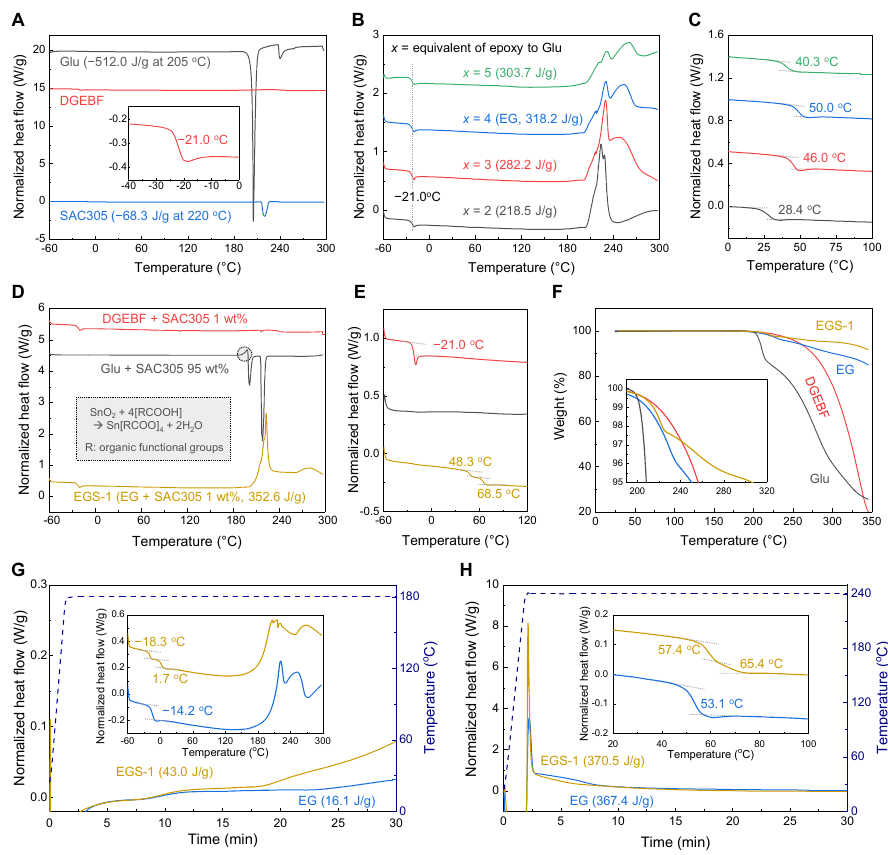
Figure 2. Thermal reaction between DGEBF, Glu, and SAC305. ( A ) Dynamic DSC results of Glu, DGEBF, and SAC305. The inset graph is an expanded curve of DGEBF, exhibiting uncured T g . ( B , C ) 1st dynamic ( B ) and 2nd dynamic ( C ) DSC curves between DGEBF and Glu with different equivalent ratios ( x ). The mixture of DGEBF and Glu with x = 4 was deemed to be optimal and abbreviated as EG. ( D , E ) 1st dynamic ( D ) and 2nd dynamic ( E ) DSC curves of DGEBF/Glu/EG with SAC305. Inset chemical reaction ( D ) is related to the marked exothermic reaction. EG with 1 wt% of SAC305 was designated as EGS-1. ( F ) Dynamic TGA results of DGEBF, Glu, EG, and EGS-1. The inset shows an expanded high-temperature region. ( G , H ) Isothermal DSC results of EG and EGS-1 at 180 °C ( G ) and 240 °C ( H ) for 30 min. The inset curves exhibit 2nd dynamic DSC scans after the corresponding isothermal ones.